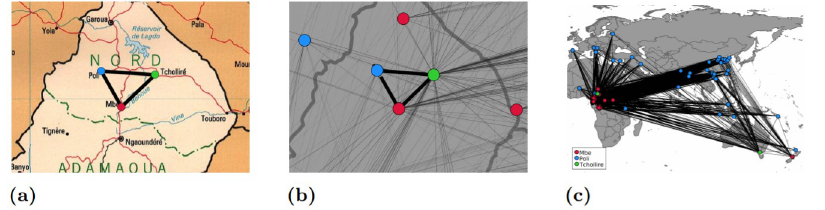
Fig 3. Pattern-based toponym identification. (a) Point pattern of the toponyms Mbe, Poli, and Tchollire detected in the image. (b) Point pattern of the corresponding geographic coordinates to the toponyms. (c) Full view of all candidate gazetteer matches and their point patterns. The map image is from the University of Texas at Austin’s Perry- Casta ñ eda Library (PCL) Map Collection and is in the public domain: https://maps.lib.utexas.edu/maps/africa/ cameroon_pol98.jpg. The geodata used to render country outlines is from © Natural Earth data and is in the public domain.